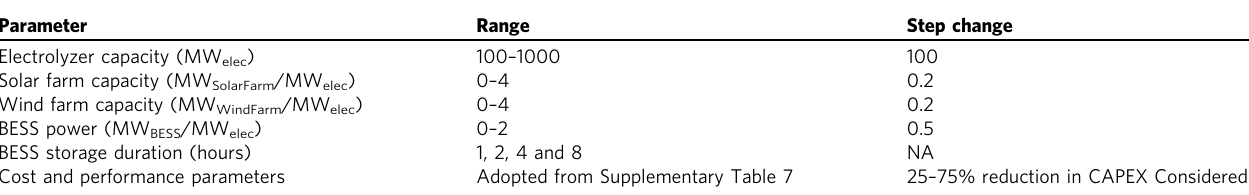
Table 3 Input ranges considered for the best performance